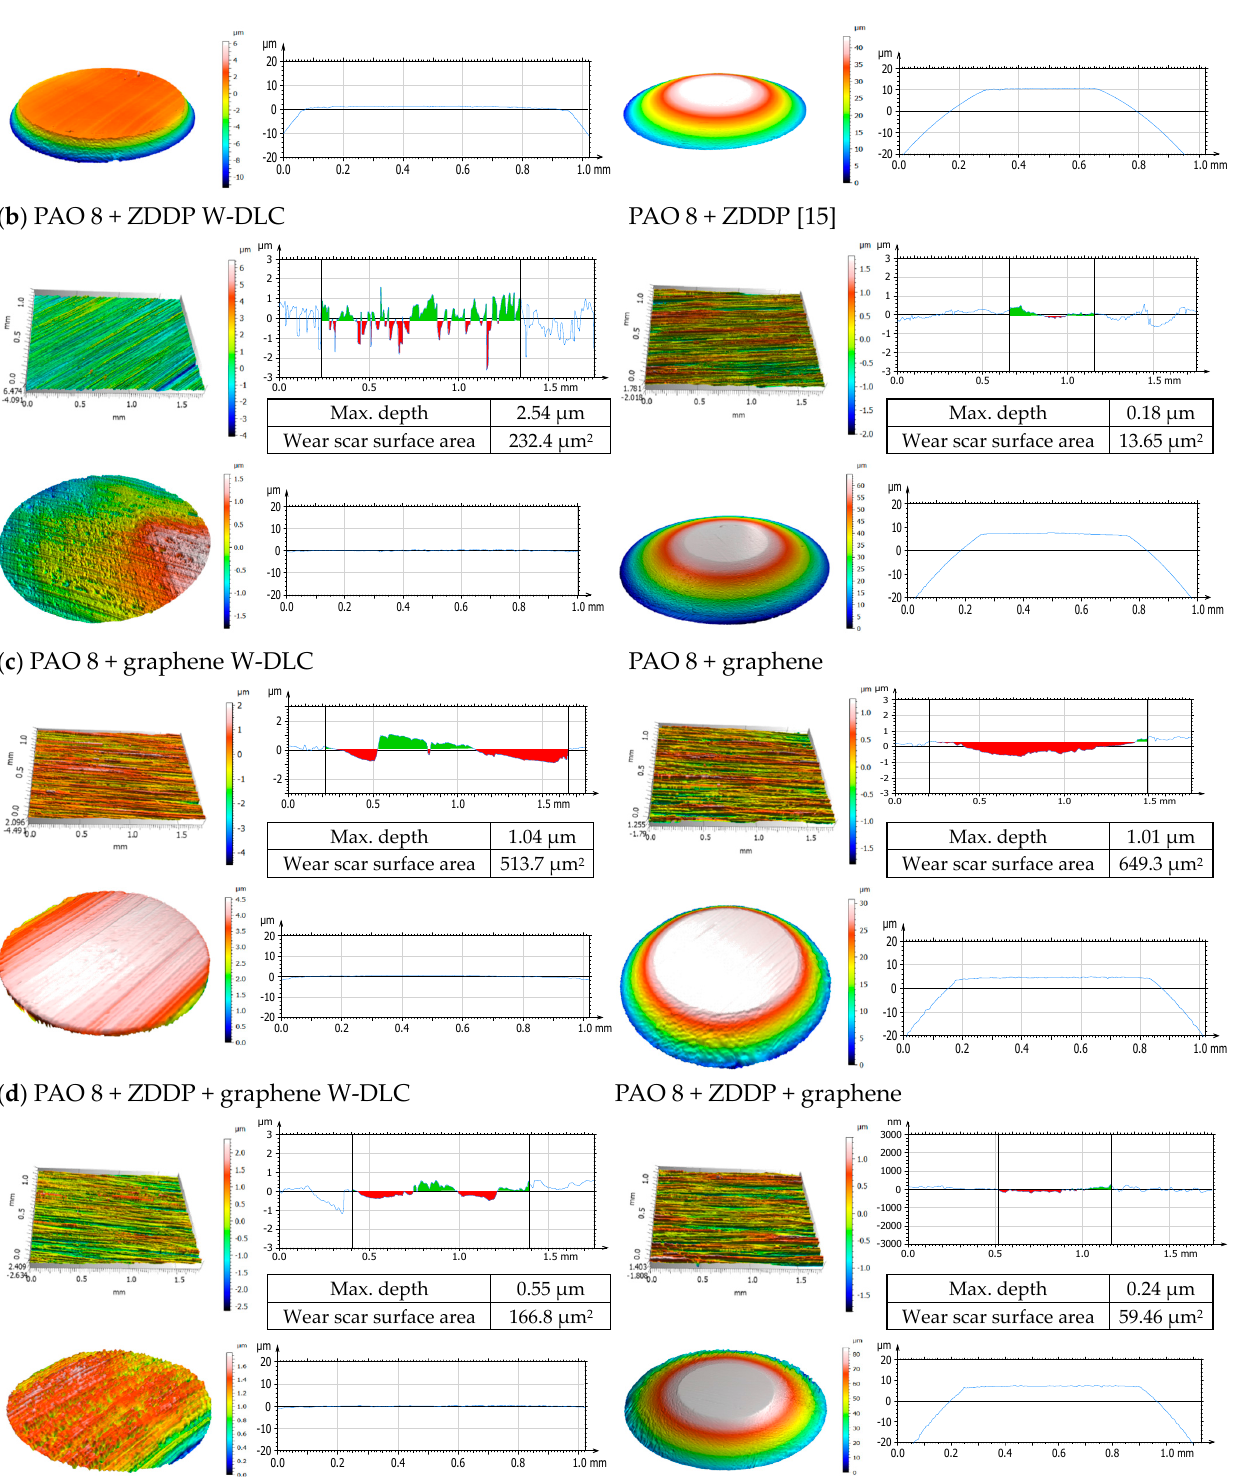
Figure 5. Isometric views and primary profiles of the discs and balls after the tribological tests: ( a ) PAO 8, ( b ) PAO 8 + ZDDP, ( c ) PAO 8 + graphene and ( d ) PAO 8 + ZDDP + graphene. The surface texture parameters obtained for the discs and balls before and after the tribological tests, shown in Table 6, are: Sa—arithmetic mean height, Sq—root mean